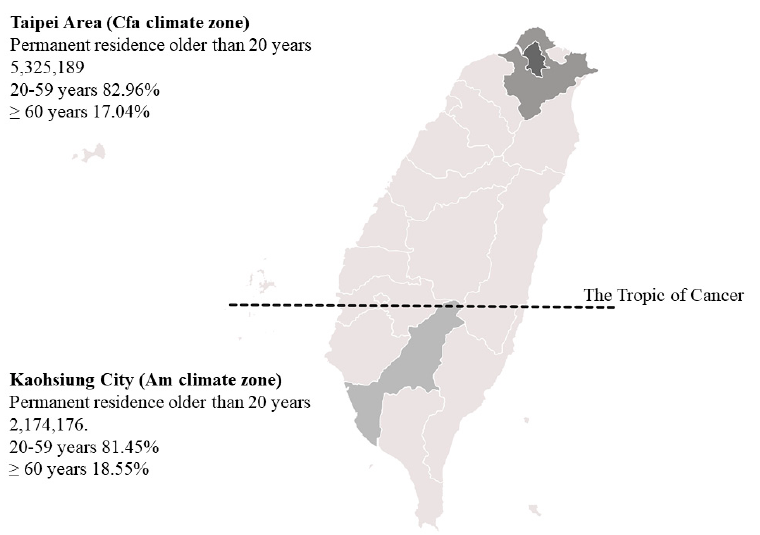
Figure 1. Populations and geographic and climate features of Taiwan. The Tropic of Cancer (23°26 ′ 12.6 ″ north of the Equator) passes through Taiwan and divides this island into tropical (south) and subtropical (north) areas. Taipei and New Taipei locate in a Cfa climate zone, while Kaohsiung City is situated in an Am climate zone.